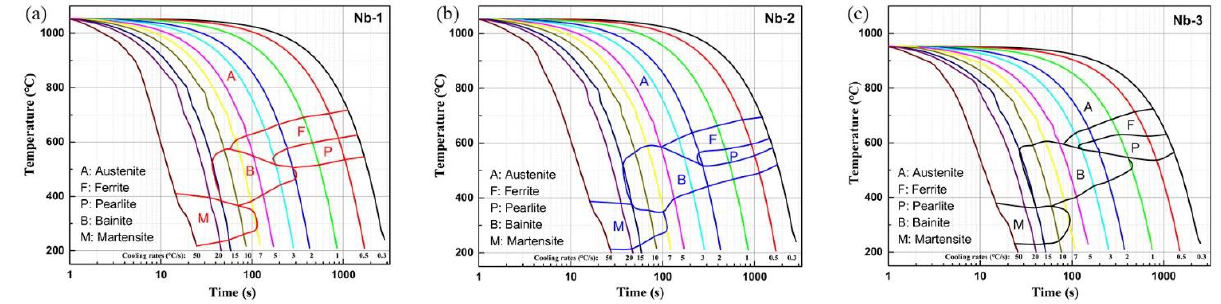
Figure 4. Dynamic CCT curve of ( a ) Nb-1, ( b ) Nb-2 and ( c ) Nb-3.